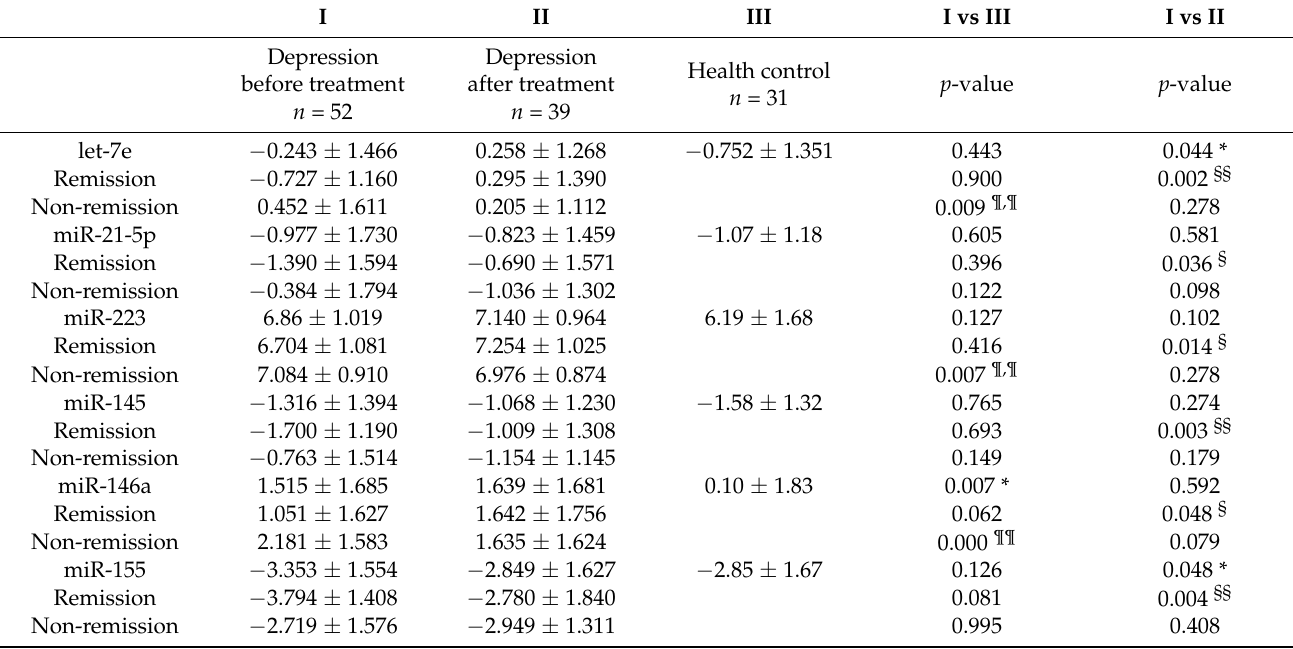
Table 3. The difference of serum exosomal microRNA expression between health control and major depression groups before and after